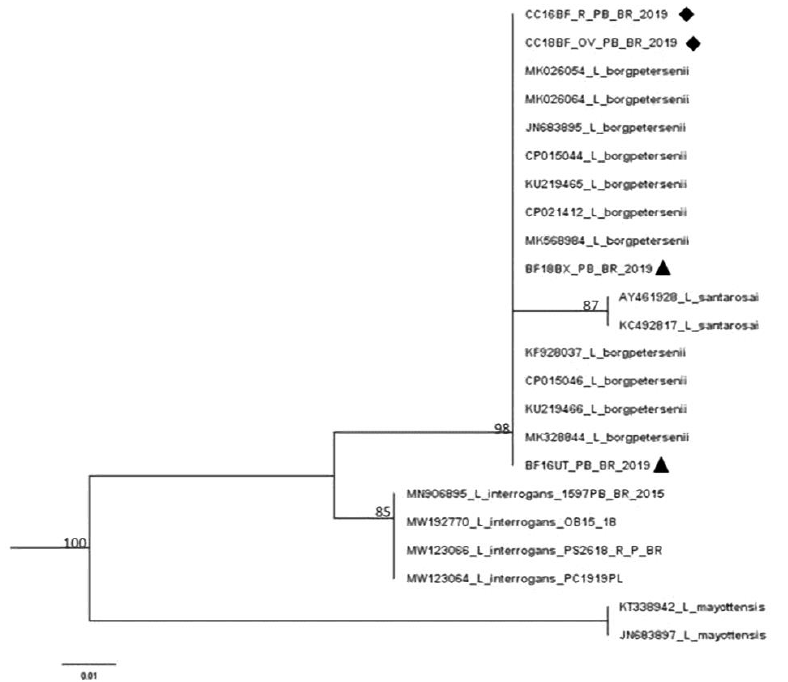
Figure 1. A phylogenetic tree based on the nucleotide sequence alignment of the LipL32 gene of Leptospira spp. constructed using the neighbor-joining method with 1000 replicates. ▲ ♦ Samples sequenced from tissues. Samples sequenced from cultures.